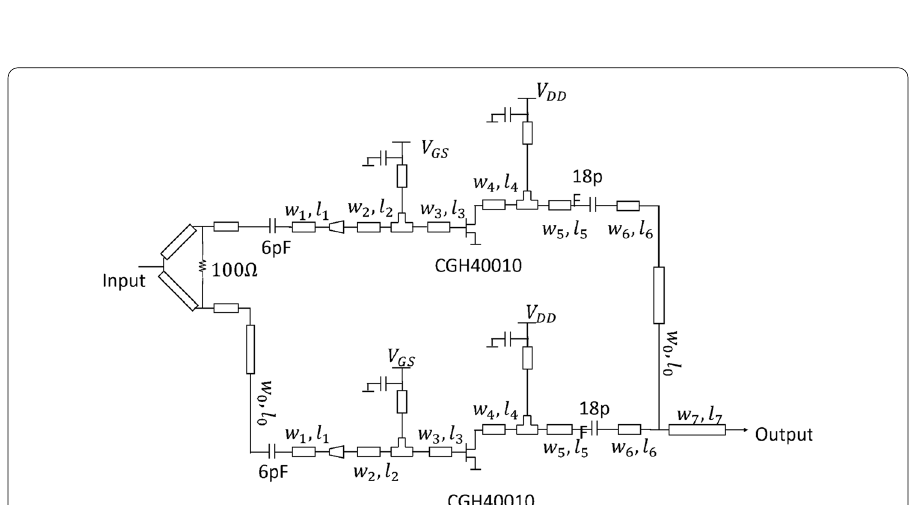
Fig. 11 Schematic of each PLM unit that forms the two-channel or four-channel CANE